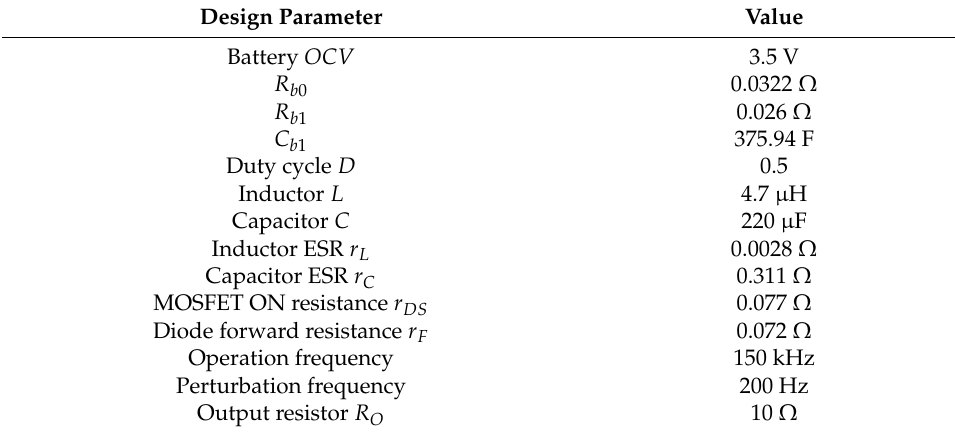
Table 1. Parameters of the theoretical analysis and simulation for ripple analysis. ESR, equivalent series